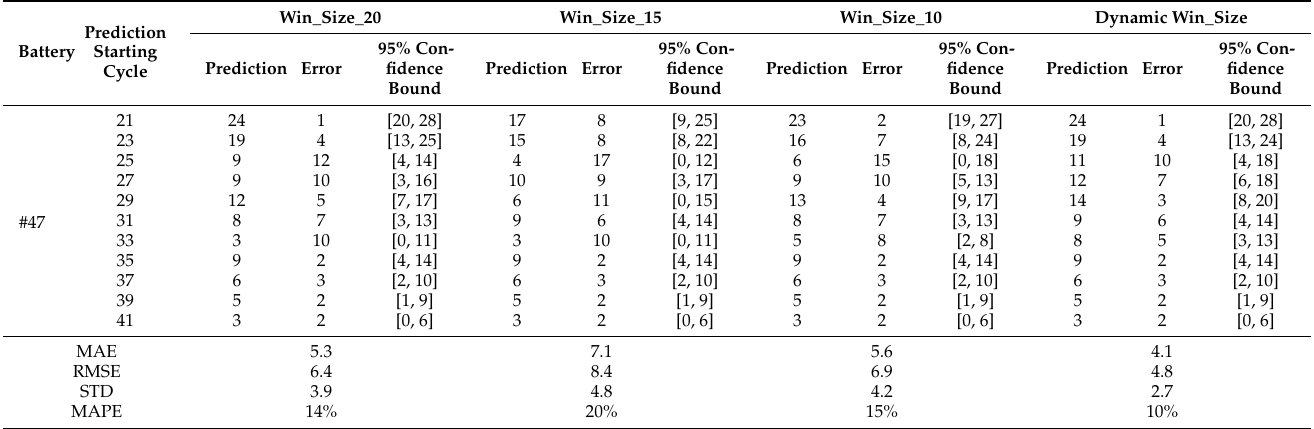
Table A4. Details of RUL prediction result of No. 47 with different window